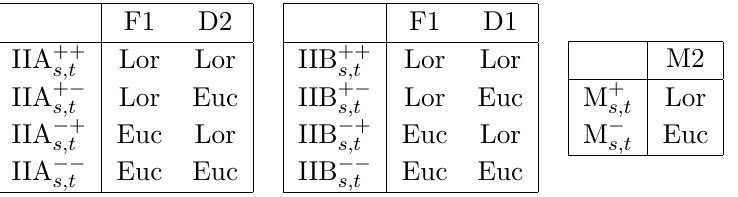
, IIB ++ , and M + 9 ; 1 9 ; 1 10 ; 1